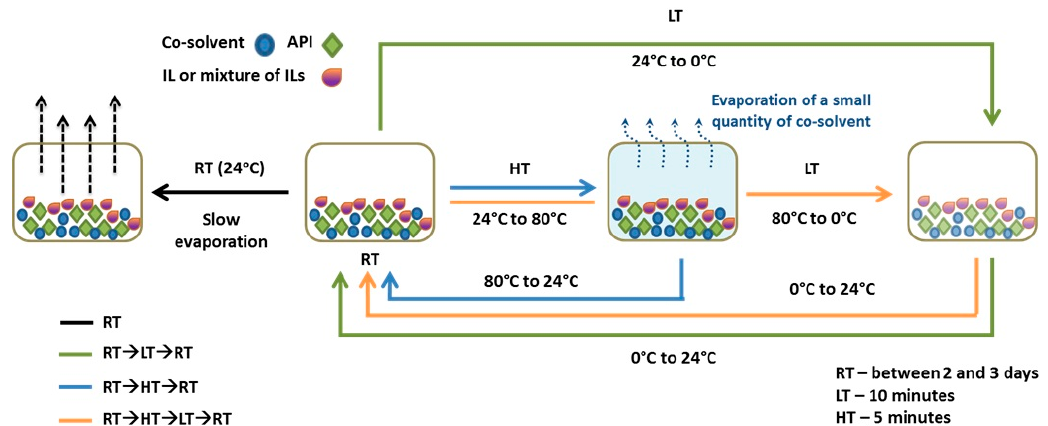
Figure 2. Schematic representation of the complete process followed to obtain GBP crystals. Conditions steps are represented with different colored arrows: RT (black); RT → HT → RT (green); RT → HT → RT (blue) and RT → HT → LT → RT (orange). RT, LT and HT stand for 24, 0, and 80 ° C, respectively [44].